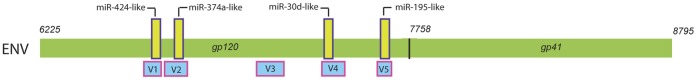
Localization of miR-like sequences in HIV envelope variable regions.This figure shows the miR–like domains listed in Tables 2 and 3 and mapped to their corresponding positions in the HXB2 envelope gene (at nucleotide positions 6682–6694, 6765–6782, 7386–7398 and 7611–7628). The miR-424-like, miR-374a-like, miR-30d-like, and miR-195-like sequences are embedded in the hypervariable regions corresponding to V1, V2, V4 and V5 respectively and are depicted in blue. No miRNA-like sequence was detected in the V3 region of the envelope.